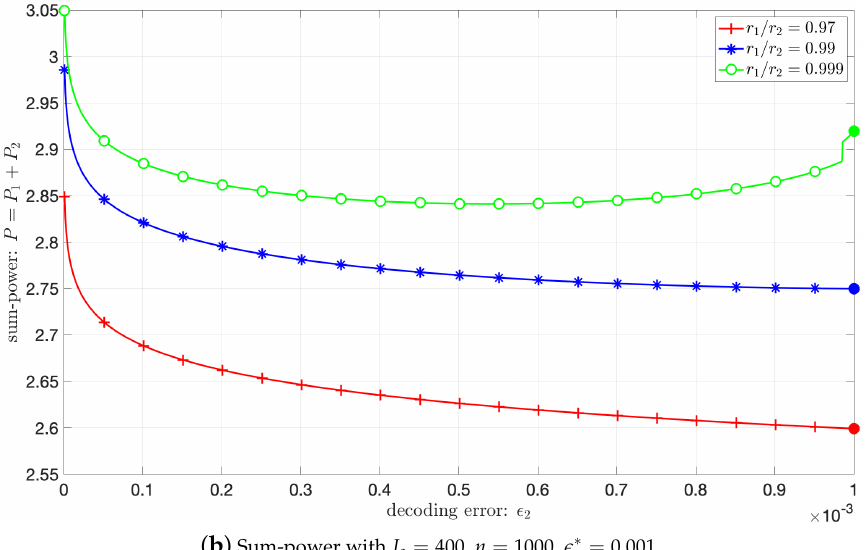
Figure 6. Minimal sum-power P m = P 1 + P 2 for the 2-user Gaussian BC with SC, for different ratios between BS-user distances r 1 / r 2 and with respect to the decoding error probability of user 2 (cid:101) 2 . The plain circles indicate the reference solution when (cid:101) 2 = (cid:101) ∗ . Reducing (cid:101) 2 induces an increase in P 2 but permits a decrease in P 1 . When the reduction in P 1 is larger than the increase in P 2 , a power gain can be obtained. This gain is more significant for small packets. Note that the vertical scale has been magnified to highlight the sum-power variations. Indeed the variations are relatively small compared to the effective sum-power